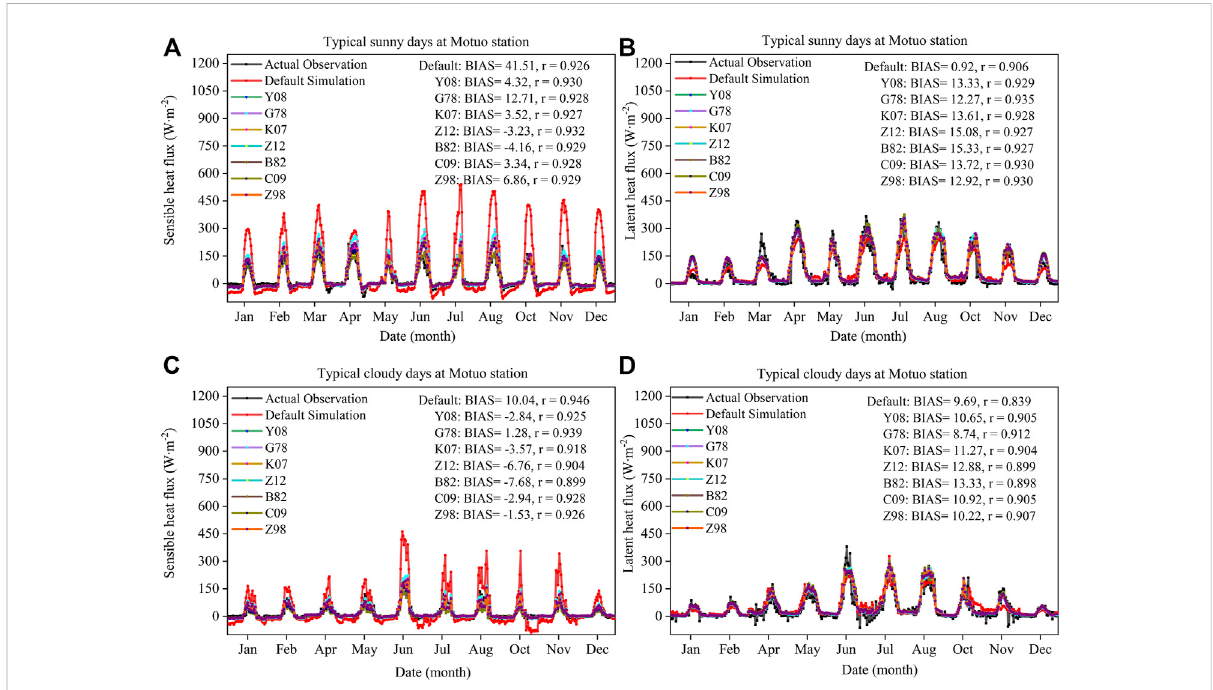
FIGURE 6 Comparison of turbulent fl uxes between the original and revised versions with seven Z 0h schemes against observations at Motuo stations, where BIAS represents the simulation deviation, r is the correlation coef fi cient, (A and C) H, (B and D) LE, unit: (W · m − 2